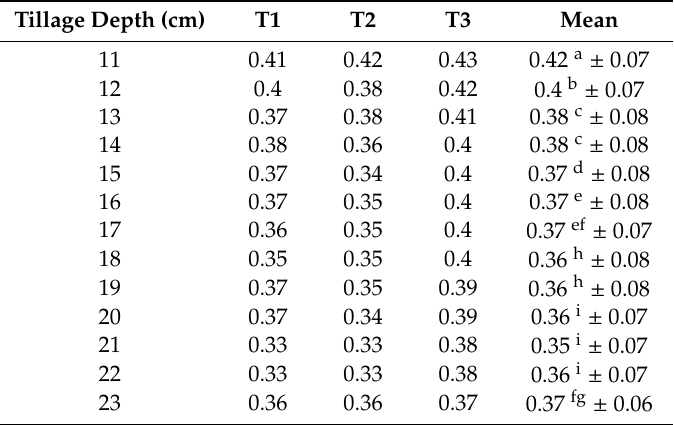
Table 12. Descriptive statistics of steering pump power (kW) according to tillage